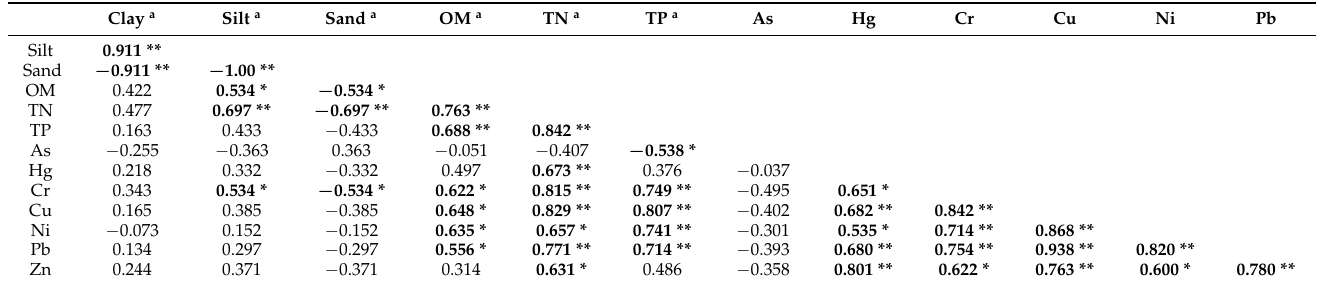
Table 3. Spearman correlation matrix for the sediment grain size, organic matter (OM), total nitrogen (TN), total phosphorus (TP), and heavy metals contents (As, Hg, Cr, Cu, Ni, Pb, Zn) in the sediments of Fengshan